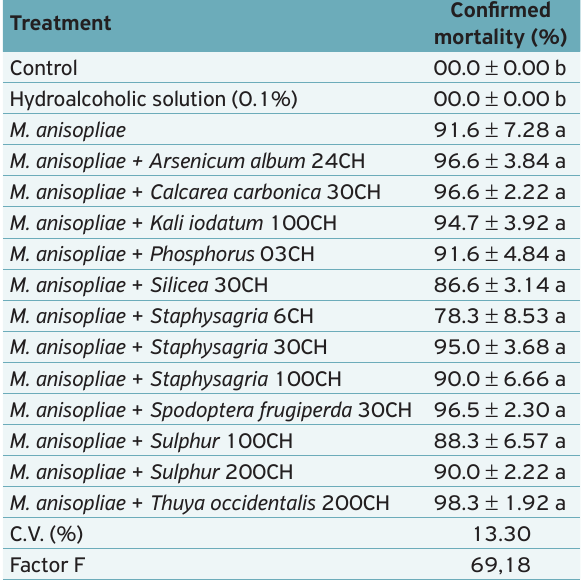
Means ( ± SE) followed by the same letter in the column for each nature does not differ by the Scott-Knott test at 5%